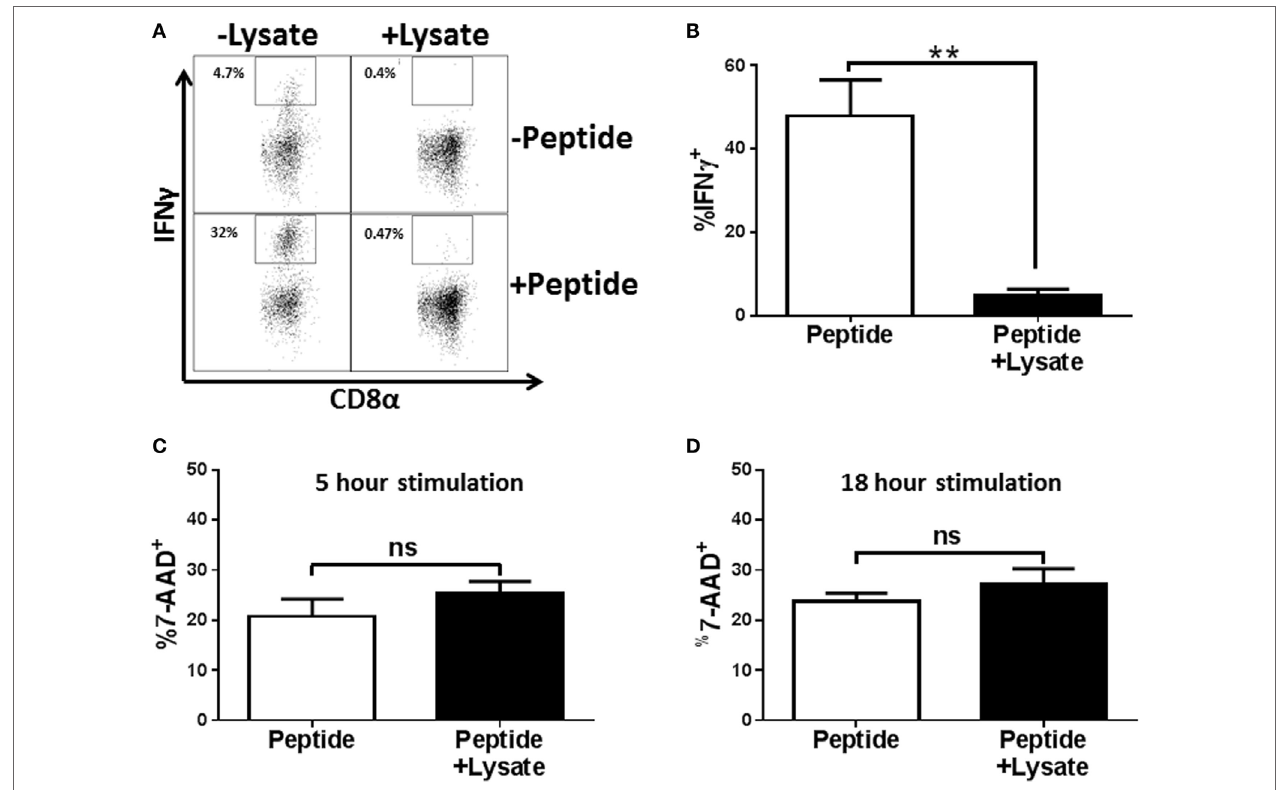
FigUre 2 | EF3030-derived lysate inhibits in vivo generated NP-specific CD8 + T cell effectors in the absence of cytotoxicity. Mice infected with influenza virus were euthanized on day 8 post infection. Mediastinal lymph nodes (MLNs) were harvested and cells stimulated ex vivo with influenza NP 147–155 peptide and the indicated amount of lysate for 5 h (a–c) or 18 h (D) . Following stimulation, cells were stained for CD8, tetramer, IFN γ , and 7-AAD. Data shown are pre-gated on CD8 + tetramer + cells. (a) Representative flow plots. (b) Averaged data from 5 independent experiments evaluating IFN γ production. Cell viability was assessed after 5 h (c) or 18 h (D) of peptide stimulation. Averaged data ± SEM from four or five independent experiments are shown in (c,D) , respectively. ** p <